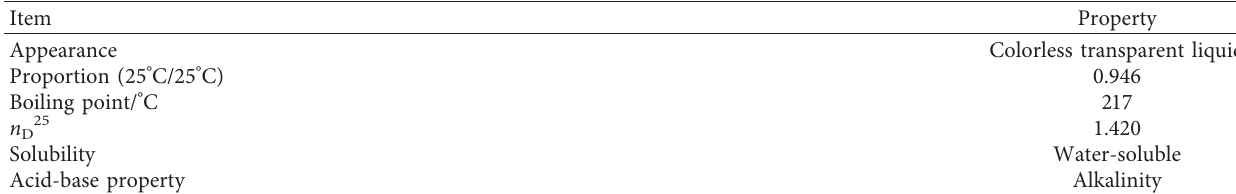
Table 2: Physical properties of KH550.